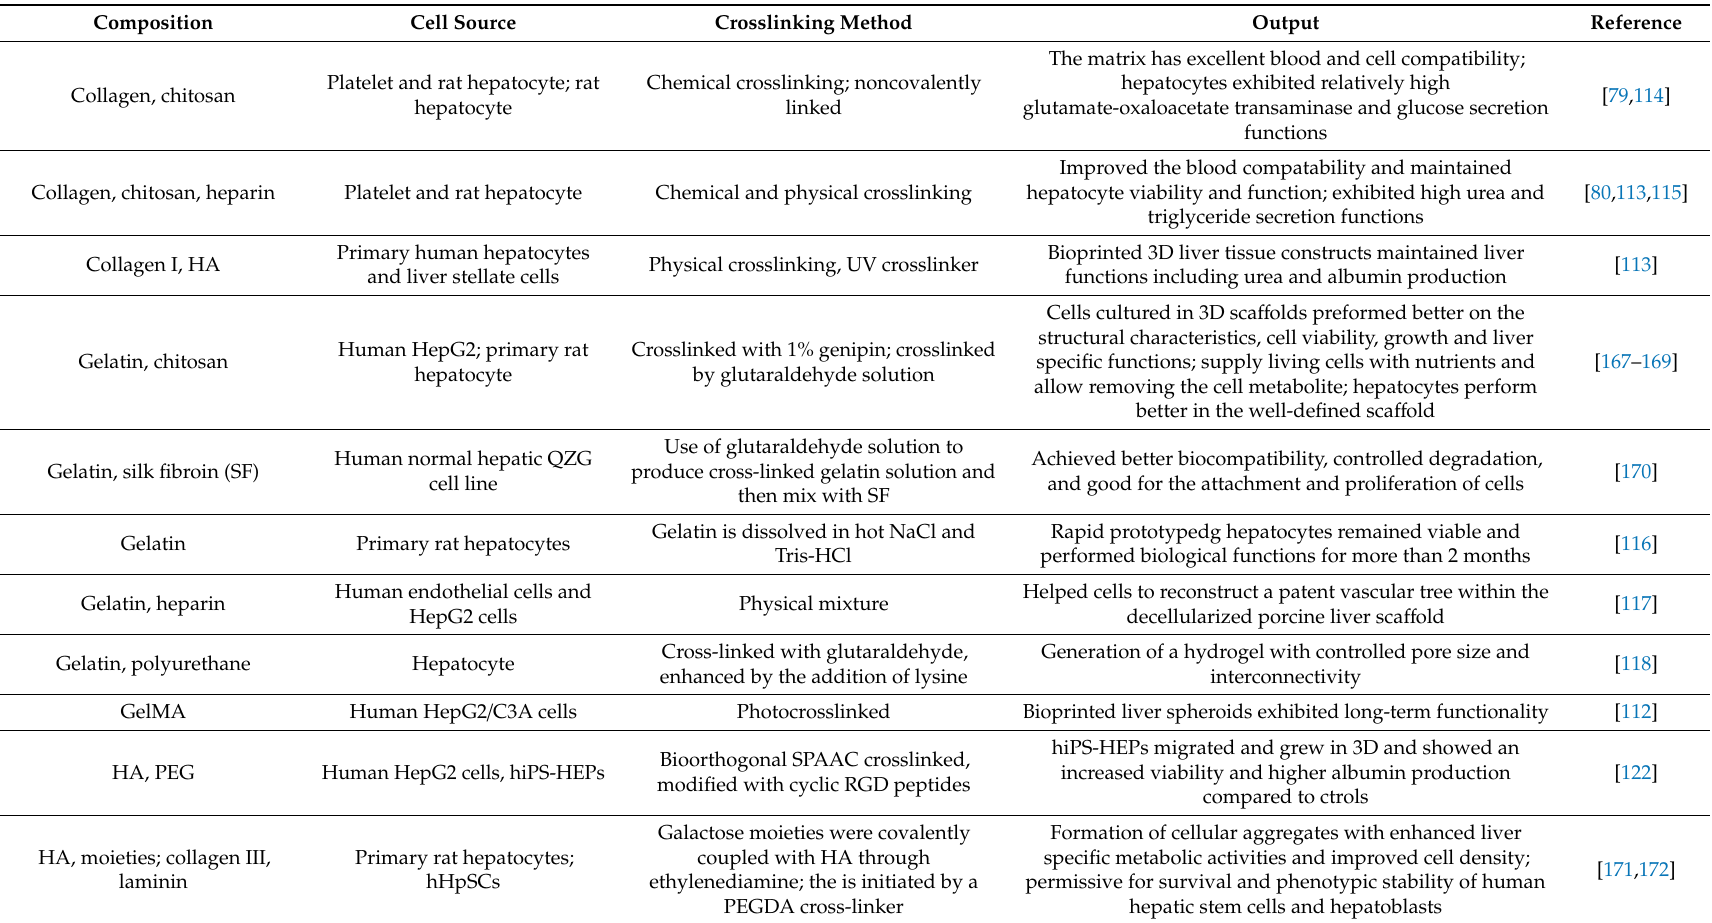
Table 3. Hydrogels designed for liver tissue